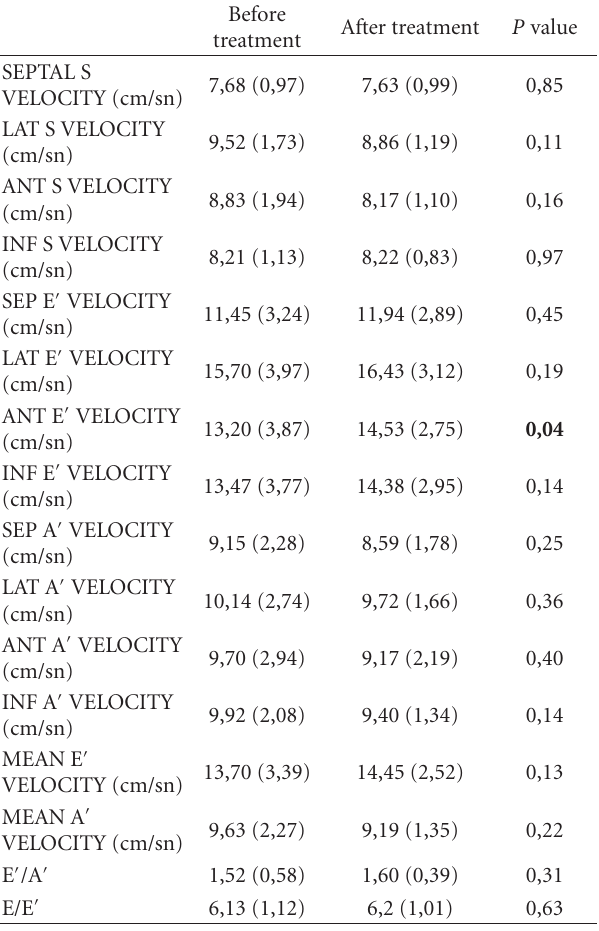
Table 6: The response of tissue Doppler-derived parameters to thyroid hormone replacement